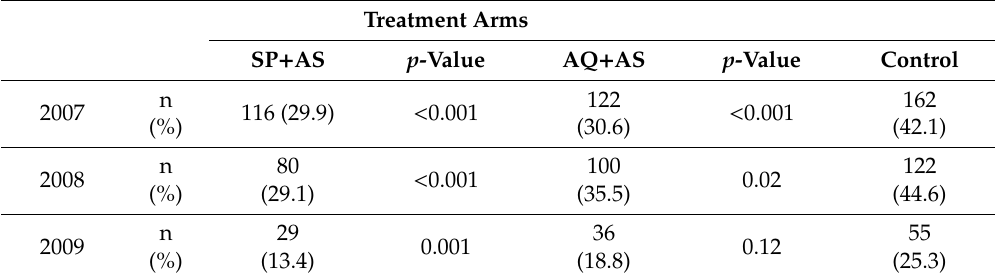
Table 3. Comparison of Anemia Prevalence by Treatment Arms in Each Study